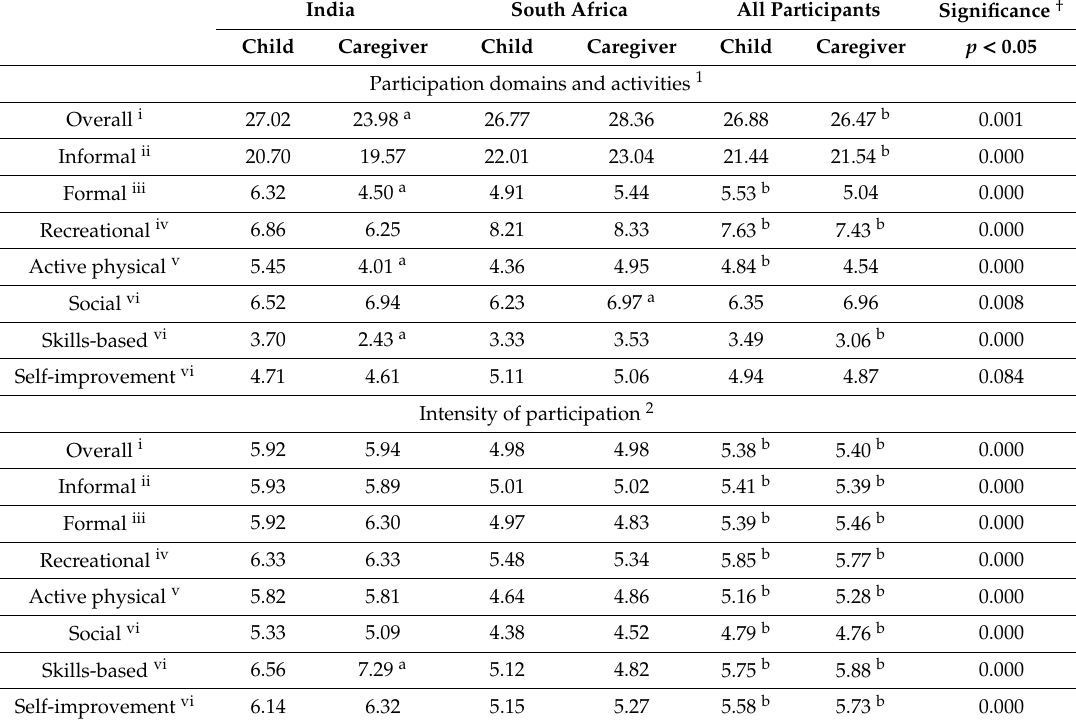
Table 2. Self-reported and caregiver-reported participation of children with intellectual disabilities in India and South Africa